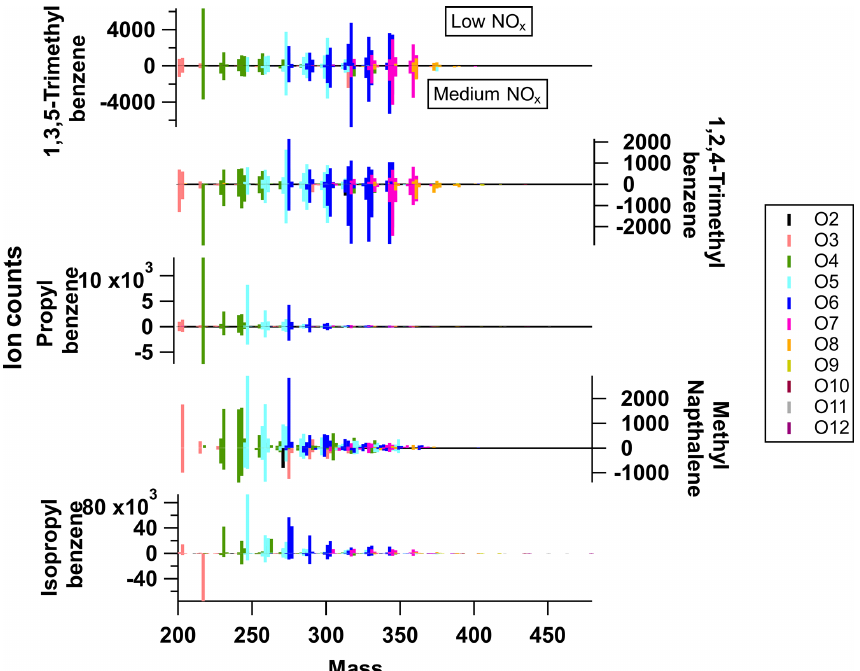
Figure 2. Average mass spectra of particle-phase measurements from I-CIMS for all precursors under low-NO x conditions (upwards) and medium-NO x conditions (downwards; negative values correspond to the magnitude of the positive